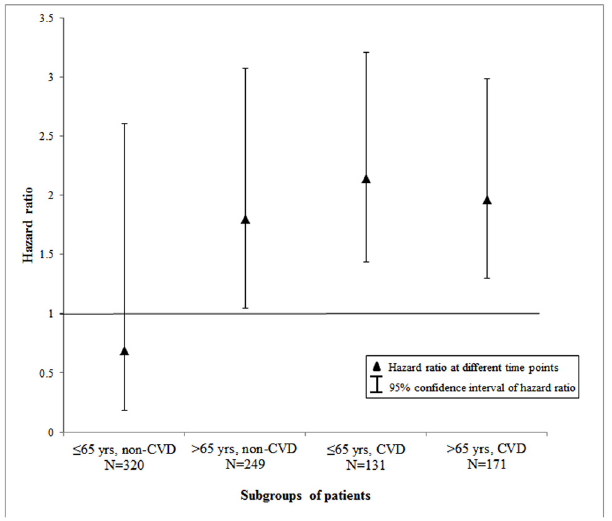
Fig 4. Hazard ratio for risk of death during 5-year follow-up for patients initiating PD compared with those initiating HD and 95% confidence intervals, stratified by age and the presence of CVD.